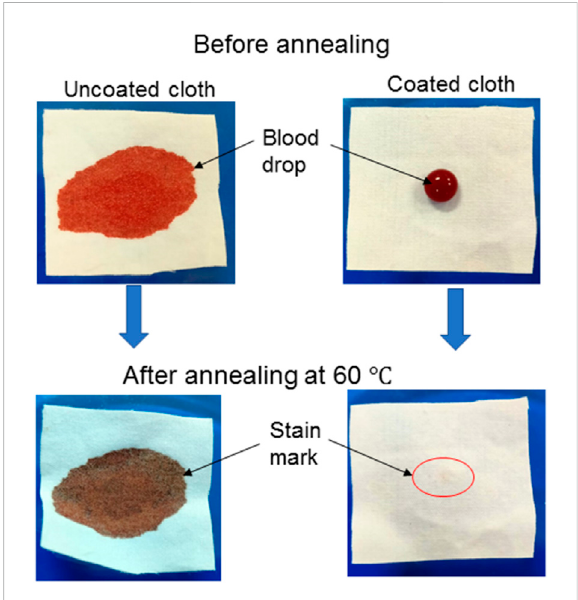
FIGURE 6 The optical images of blood droplets before and after drying on uncoatedcloth(leftthestainmark)andcoatedcloth(exhibitnegligible stain marks), showing the stain-resistant ability of both coated cloths.